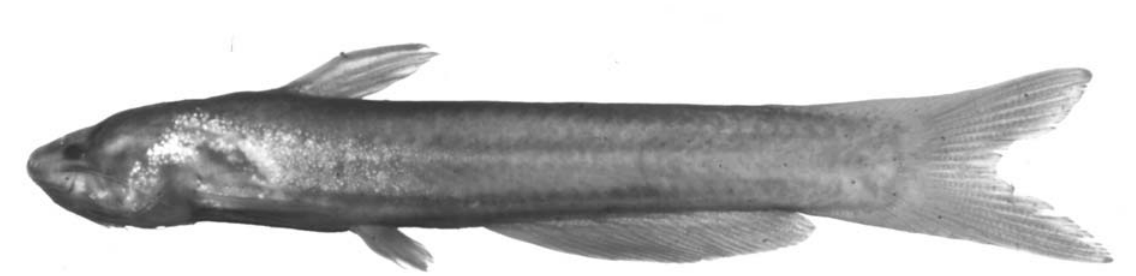
Fig. 10 . Cetopsidium roae , new species, holotype, BMNH 1972.7.27:629-642, 34 mm SL; Guyana, Rupununi River, Karanambo (3°45’N,